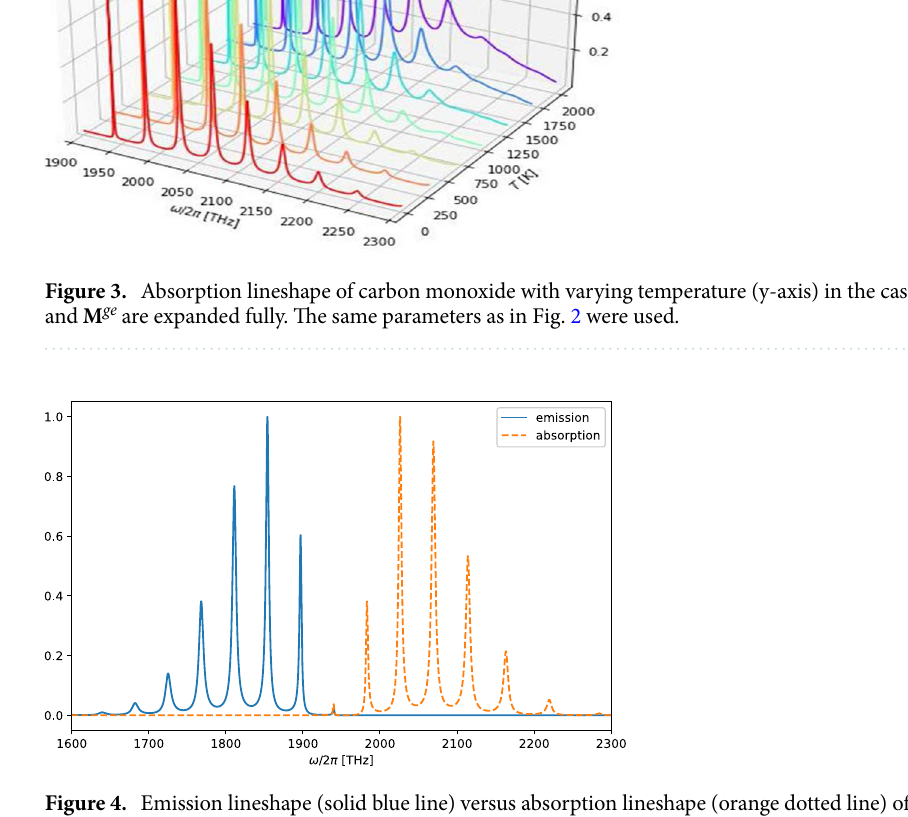
Figure 4. Emission lineshape (solid blue line) versus absorption lineshape (orange dotted line) of carbon monoxide. A breaking in the mirror symmetry is observed. Both the emission and absorption lineshapes are plotted using the same set of parameters as in Fig.